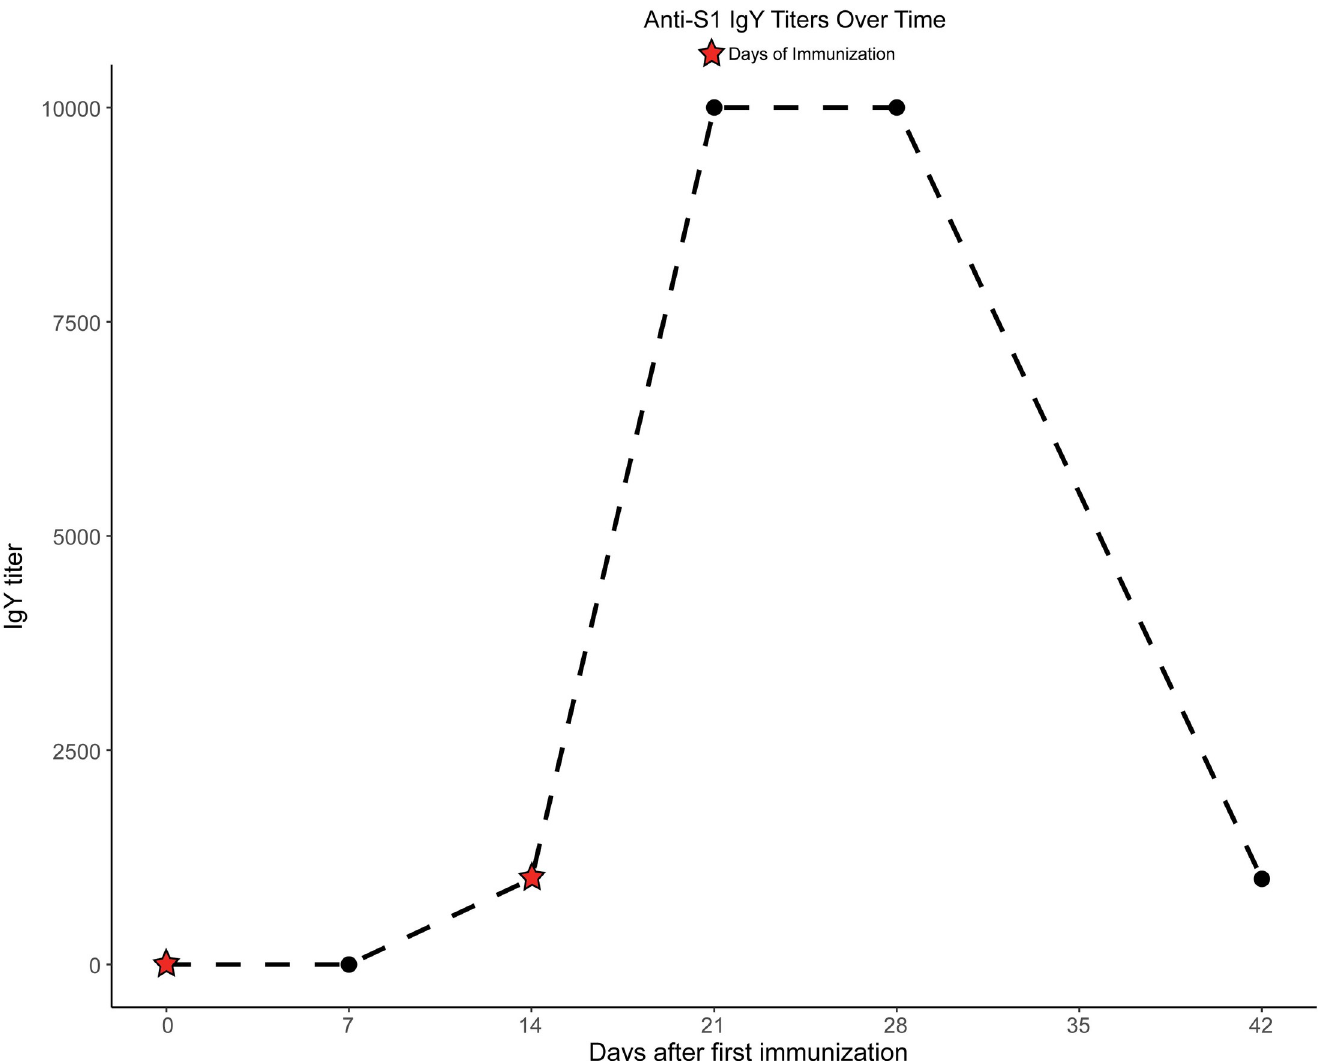
Fig 2. Titers of anti-SARS-CoV-2 S1 spike IgY in egg yolks over time. Eggs were collected from immunized hens weekly over 6 weeks following the first immunization and analyzed by ELISA against the S1 antigen. Stars indicate dates of immunization injections.